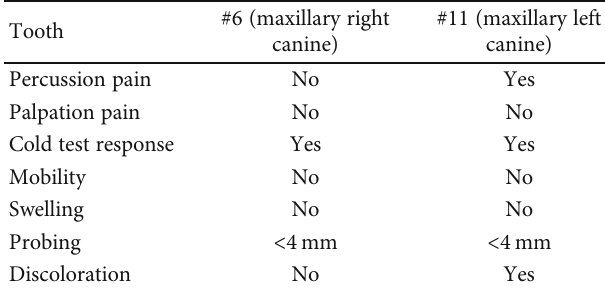
Table 1: Summary of diagnostic tests.